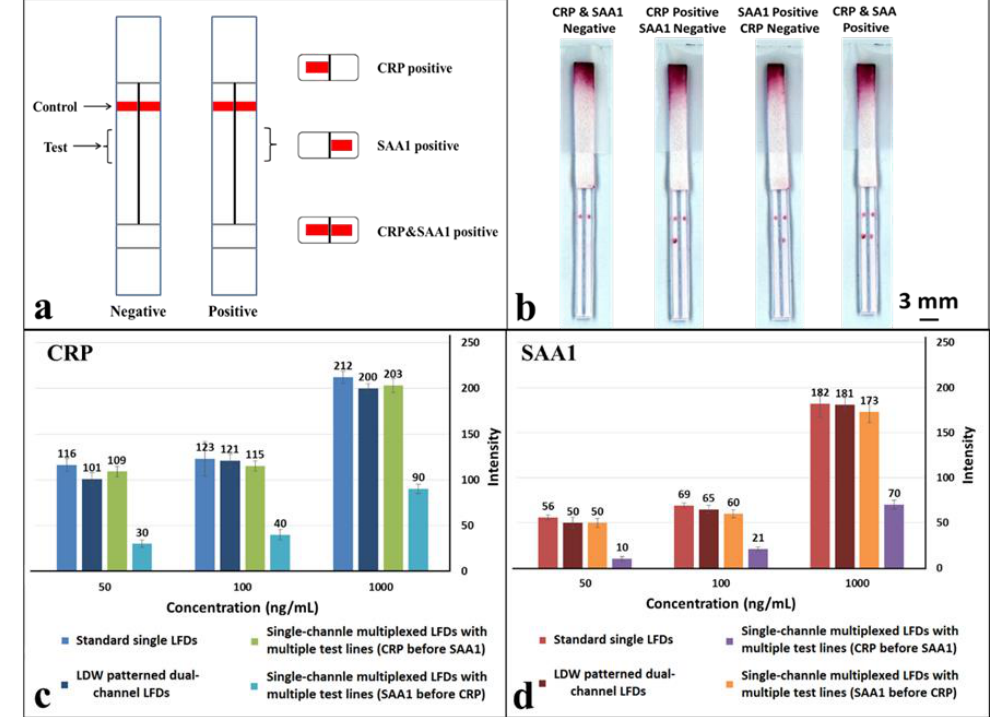
Figure 6. ( a ) Schematic of the laser direct-write (LDW) patterned multiplexed LFD with multiple channels for multiplexed detection of CRP and SAA1; ( b ) scanned image shows the multiplexed detection of CRP and SAA1 using LDW patterned dual-channel LFDs described in ( a ); ( c , d ) plots showing direct comparison of the measured colour intensities of test lines that appeared in standard single LFDs, single-channel multiplexed LFDs and our LDW-patterned dual-channel LFDs for detection of CRP & SAA1 respectively at concentrations of 50 ng/mL, 100 ng/mL and 1 µg/mL. Error bars indicate the standard deviation for 3 individual measurements.